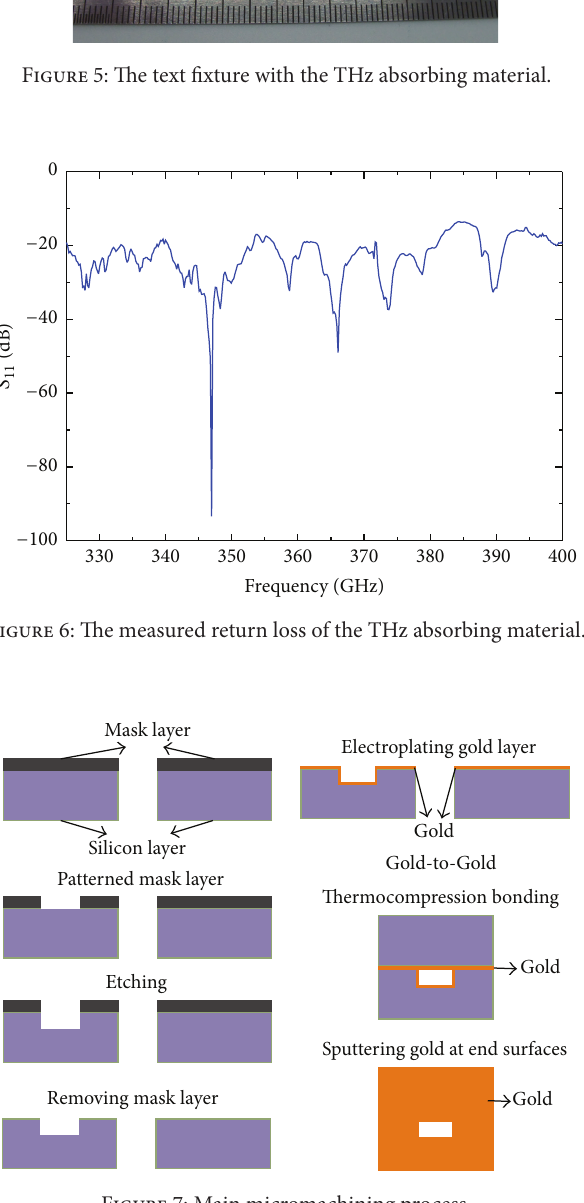
Figure 7: Main micromachining process.